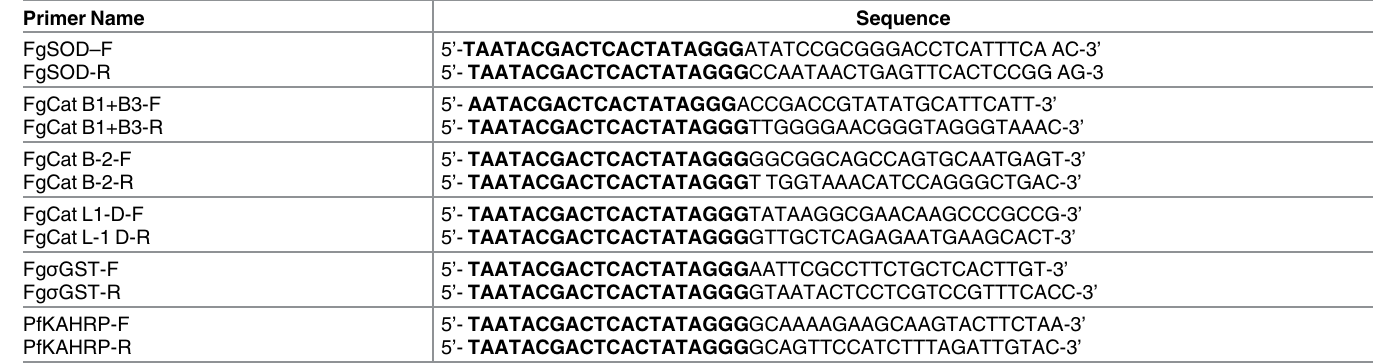
Table 1. Sense and anti-sense primers tailored with T7 promoter sequence at 5’ end (in bold) for in vitro transcription of dsRNA trigger against six target genes of F . gigantica and for irrelevant control dsRNA against Plasmodium falciparum